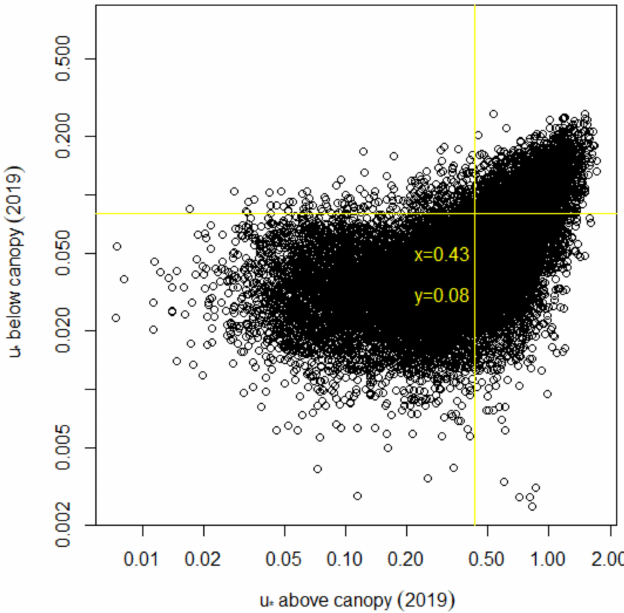
Figure 5. Relation between below canopy u* vs. above canopy u* (black circles; 30 min resolution; m s − 1 ; both axes are in logarithmic scale). The yellow vertical and horizontal line indicate the estimated above and below the canopy u* thresholds, respectively, which distinguish weak turbulent periods from the period when the canopy layers were fully